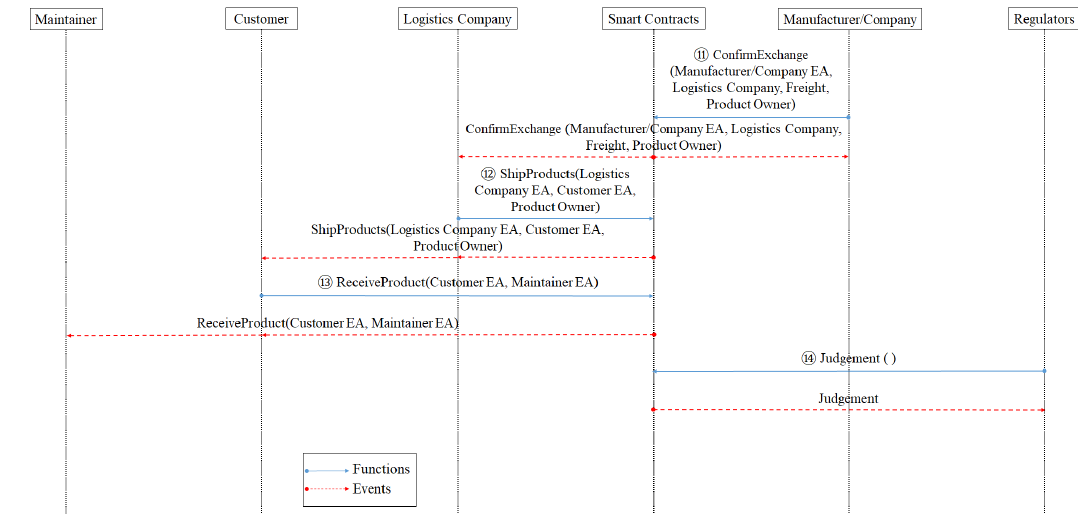
Figure 6. System Sequence Diagram 3.